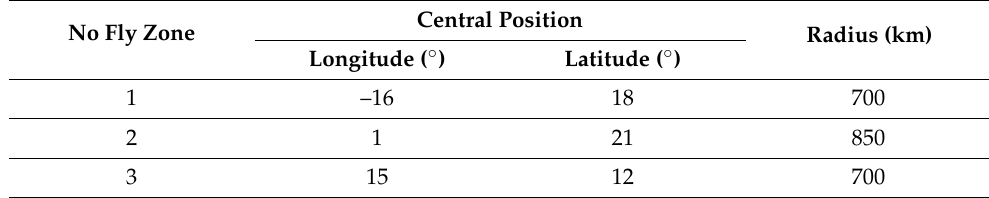
Table 1. Locations of no fly zones.